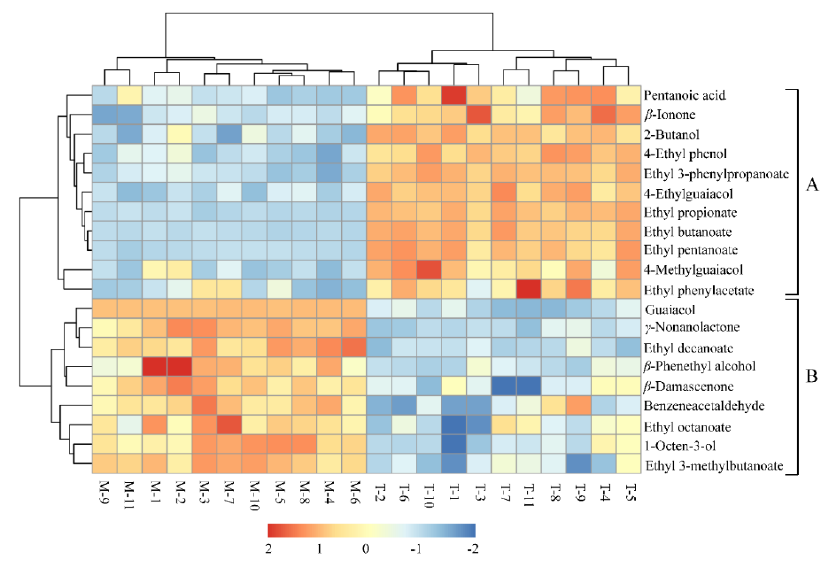
Figure 4. Heat map of the key aroma compounds maker between modern type xiaoqu Baijiu and traditional type xiaoqu Baijiu. traditional type xiaoqu